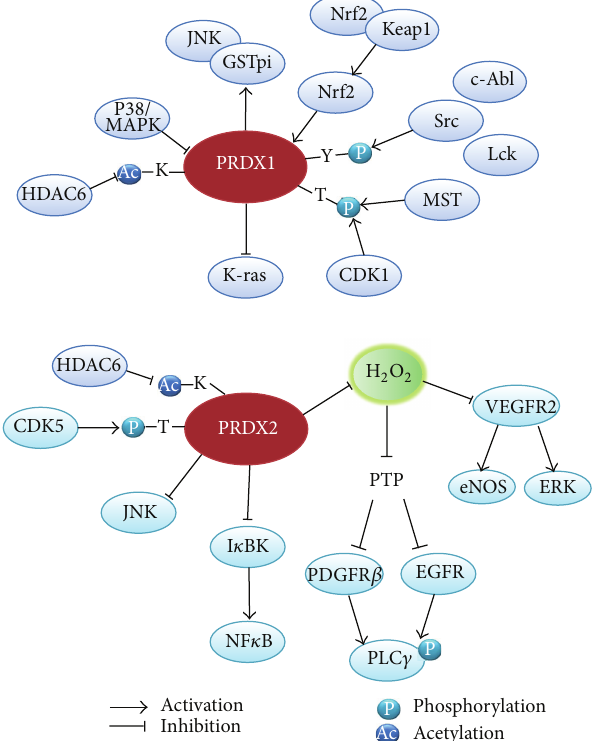
Figure 1: Interaction of typical 2-Cys Prxs with signaling molecules in the phosphorylation and acetylation networks. Prx1 and Prx2 interact directly or indirectly via ROS with the kinases/phosphatases and regulate their activation. In addition, the activities of these two Prxs are also controlled by phosphorylation and acetylation. Note that the Prx1 expression is known to be controlled by a transcription factorNrf2(nuclearfactorE2-relatedfactor2)underoxidativestress